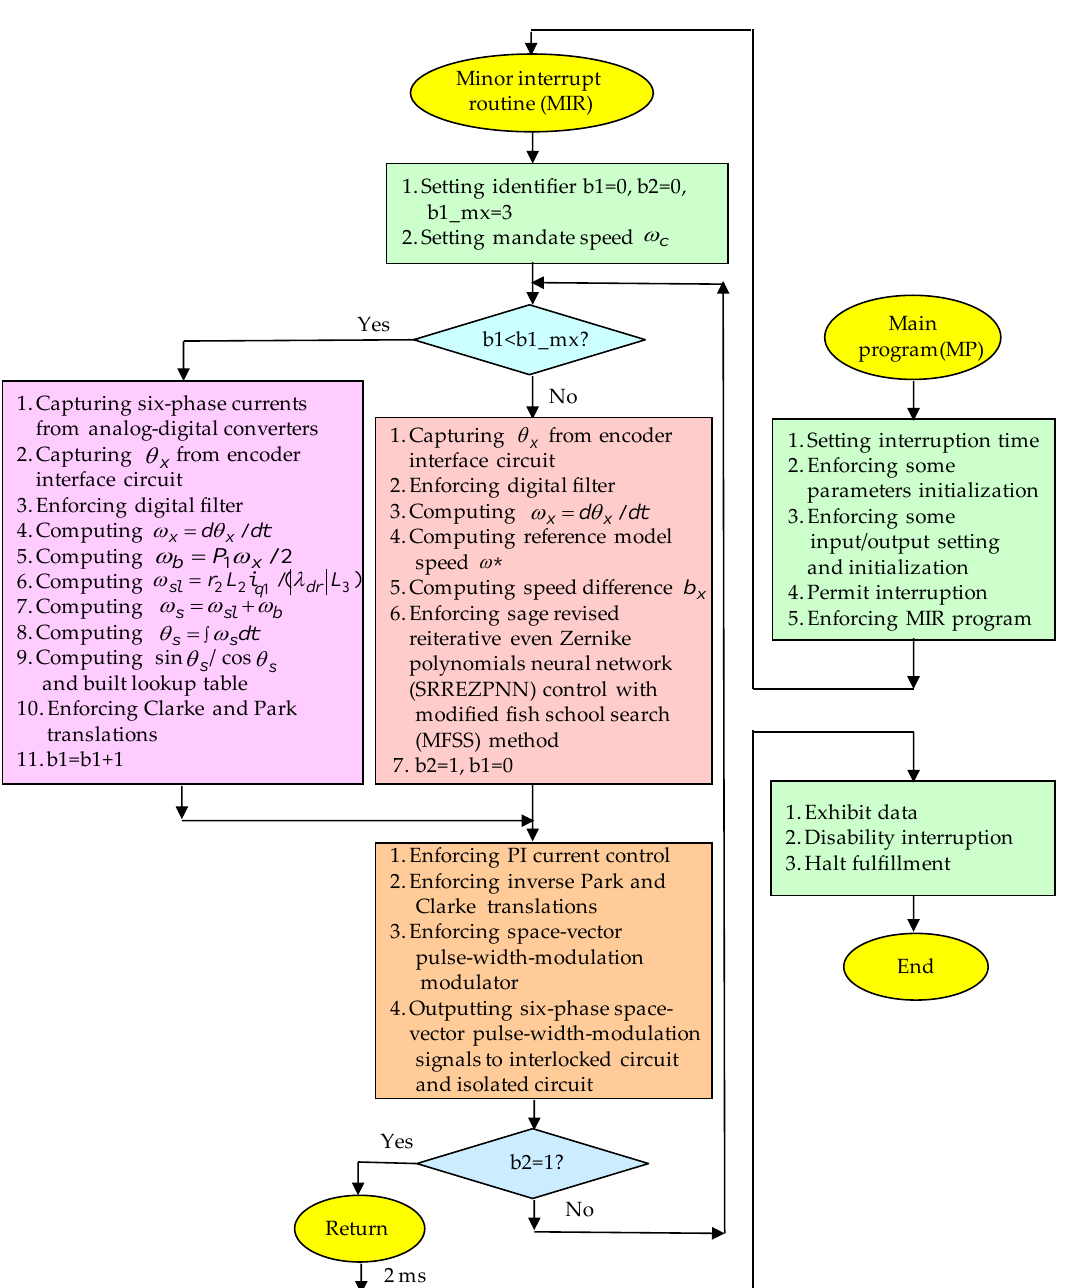
Figure 5. Flowchart of the carried-out program by using digital signal processor (DSP) control system.